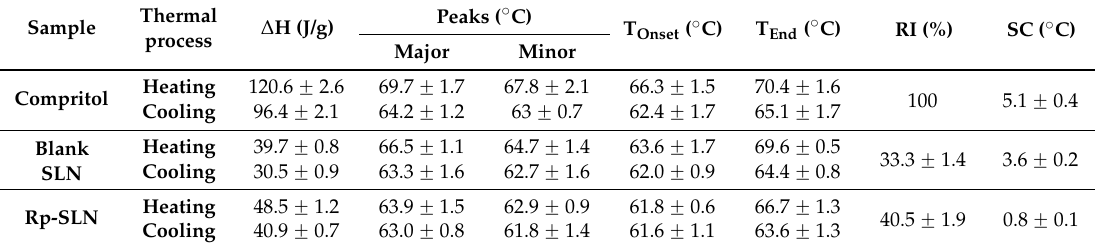
Table 2. Thermodynamic parameters measured for blank and Rp-SLN in comparison with bulk